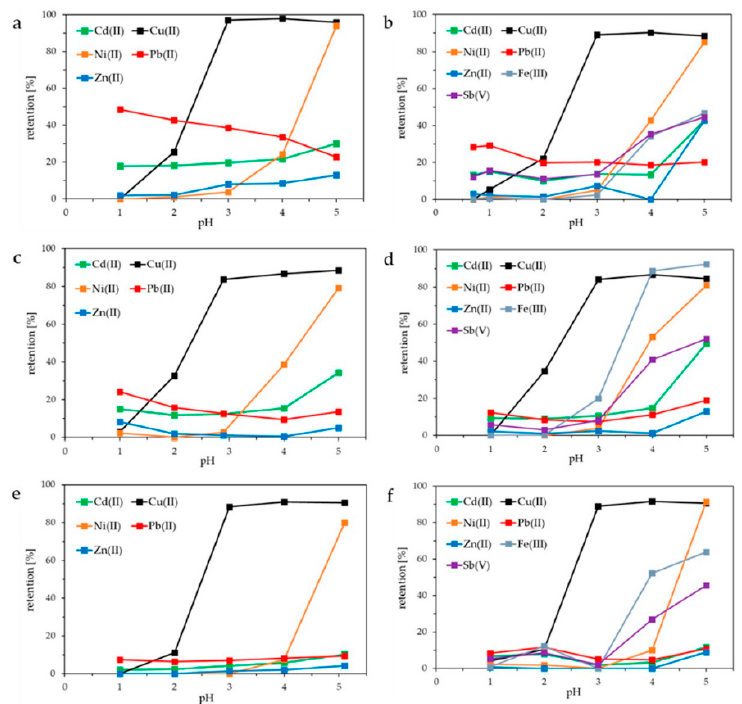
Figure 2. Influence of pH on the retention of Cd(II), Cu(II), Ni(II), Pb(II), Zn(II), Fe(III), and Sb(V) using fly ash extracts from KEBAG Zuchwil and MVA Ingolstadt: ( a , b ) hyperbranched polyethyleneimine (HB-PEI) = 10.0 g L − 1 (Zuchwil), 7.9 g L − 1 (Ingolstadt); ( c , d ) partially ethoxylated polyethyleneimine (PE-PEI) = 9.4 g L − 1 (Zuchwil), 7.7 g L − 1 (Ingolstadt); ( e , f ) modified polyethyleneimine (MOD-PEI) = 9.7 g L − 1 (Zuchwil), 8.0 g L − 1 (Ingolstadt).